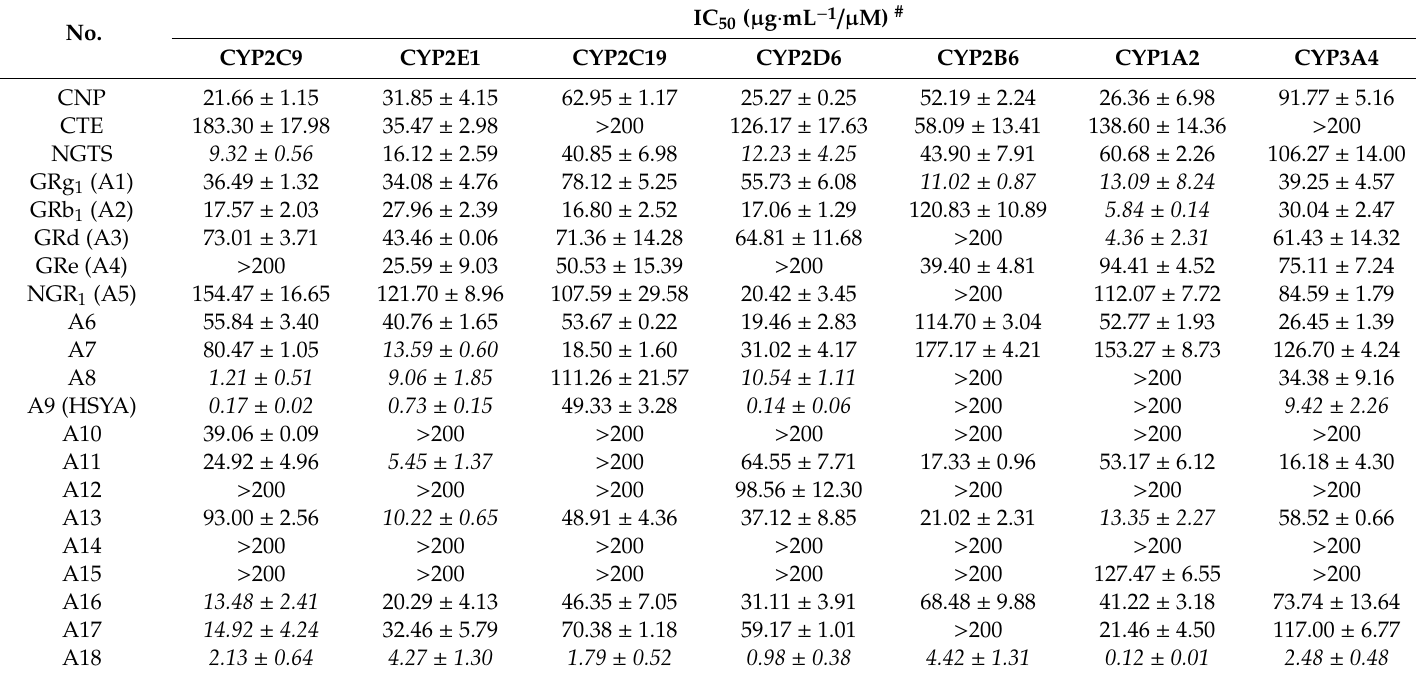
Table 2. IC 50 values of CTE, NGTS, CNP, and the 18 representative compounds for inhibiting cytochrome p450 (CYP450)